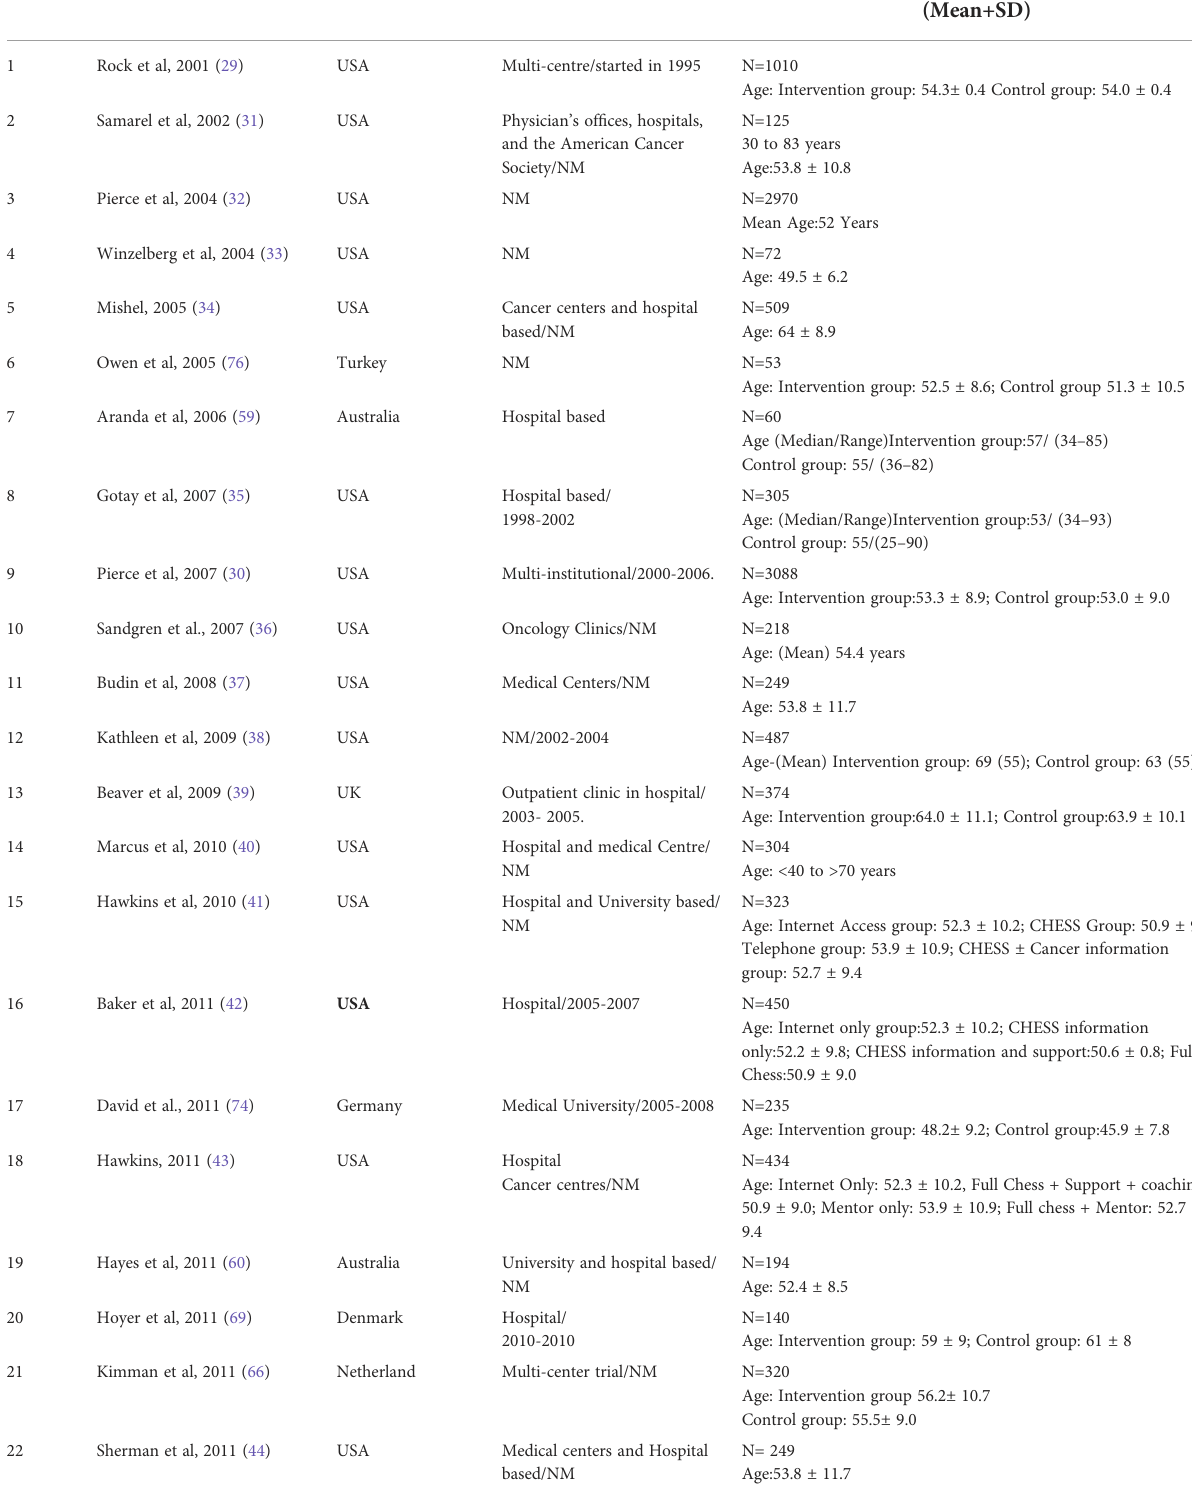
TABLE 2 Characteristics of included